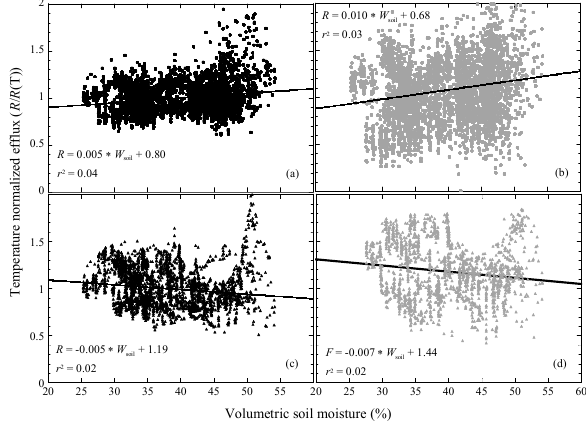
Fig. 5. Fig. 5. Temperature normalized soil CO 2 efflux, ratio between mea- sured soil CO 2 efflux ( R s ) and its temperature fitted value ( R s (T ) ), versus volumetric soil water content at a depth of 0.1m. (a) and (b) represent total soil CO 2 efflux and root respiration measured by the automated chamber system, and (c) and (d) represents total soil CO 2 efflux and topsoil (O a and A horizons) CO 2 efflux measured by the soil CO 2 gradient